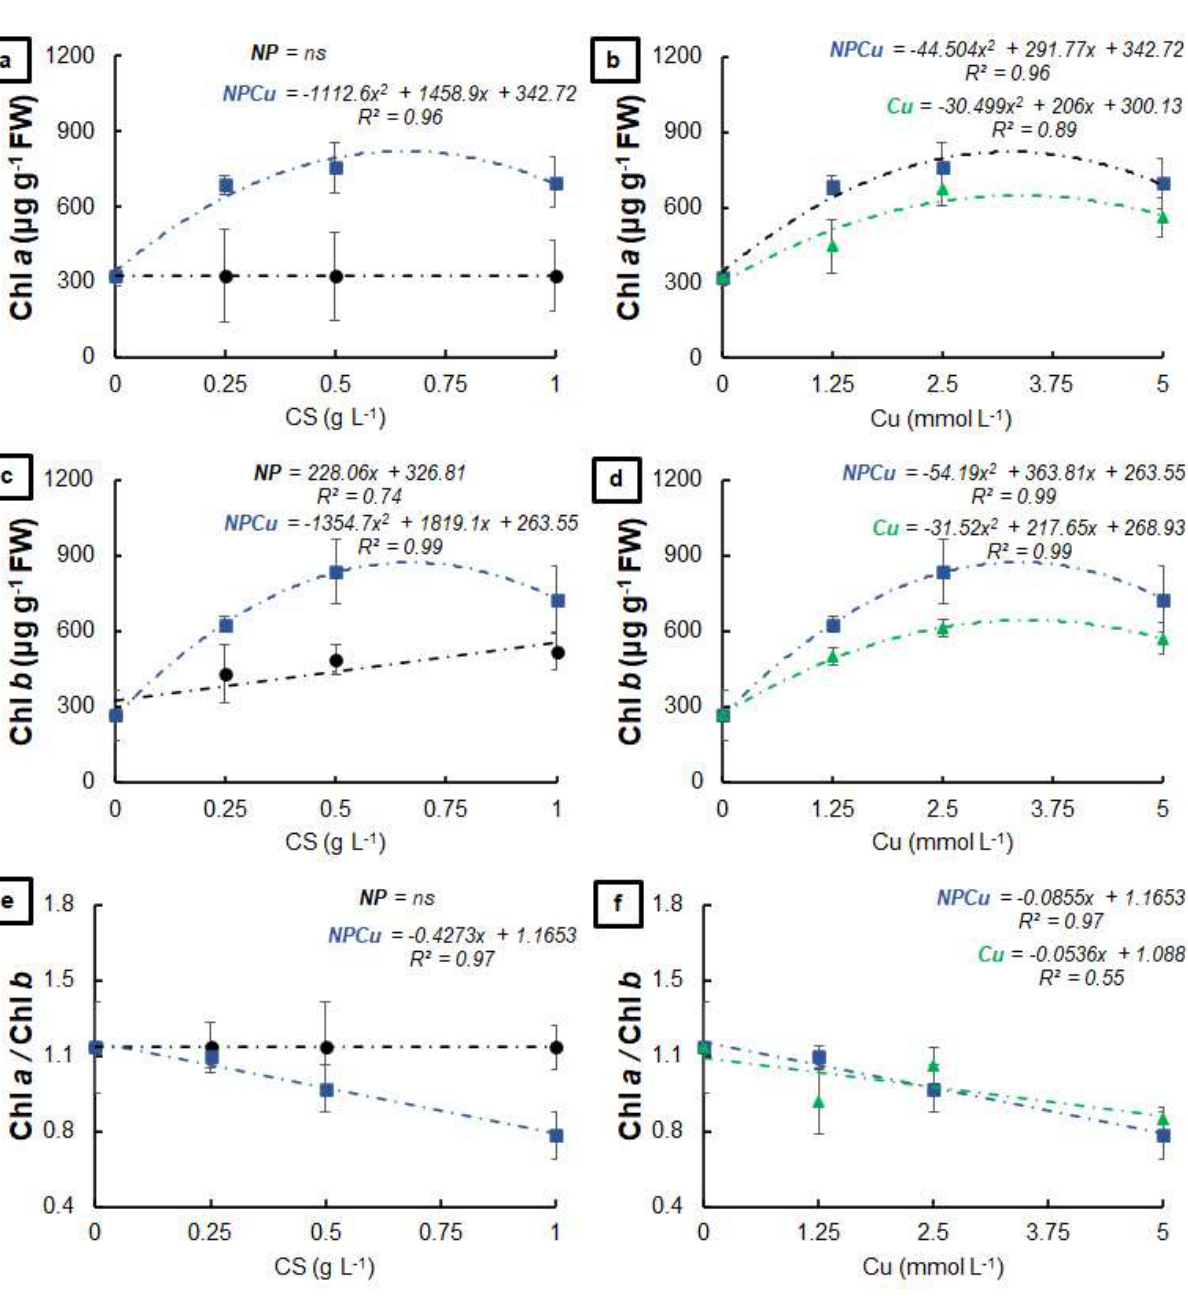
Figure 4. Chlorophyll a ( a , b ), chlorophyll b ( c , d ), and chlorophyll a /chlorophyll b ratio ( e , f ) of leaf discs of Coffea arabica cv. IPR 100 at 40 days after infection (DAI) with H. vastatrix , Before infection, the discs were treated with distilled water as a control (CONT), chitosan nanoparticles without Cu 2+ ions (NP), chitosan nanoparticles containing Cu 2+ ions (NPCu), and free Cu 2+ ions (Cu). The formulations were diluted in distilled water, obtaining the corresponding concentrations of chitosan (CS) in NP and NPCu treatments (0.25; 0.5; 1 g L − 1 ) and of Cu 2+ ions (1.25; 2.5; 5 mmol L − 1 ) in NPCu and Cu treatments. Results are expressed as mean ( n = 4) ± standard error. The model and coefficient of determination (R 2 ) are also shown ( p < 0.05). ns = not